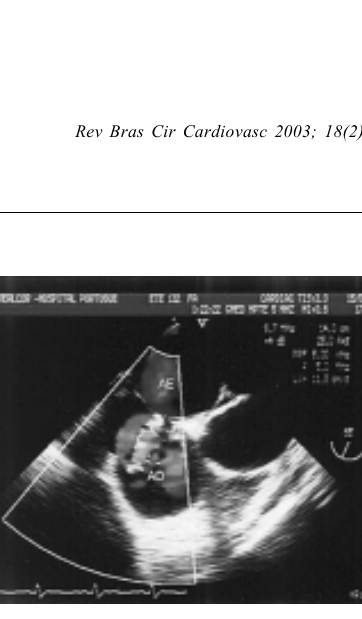
Fig. 4 – Transoesophageal echocardiogram showing the interatrial septum rupture